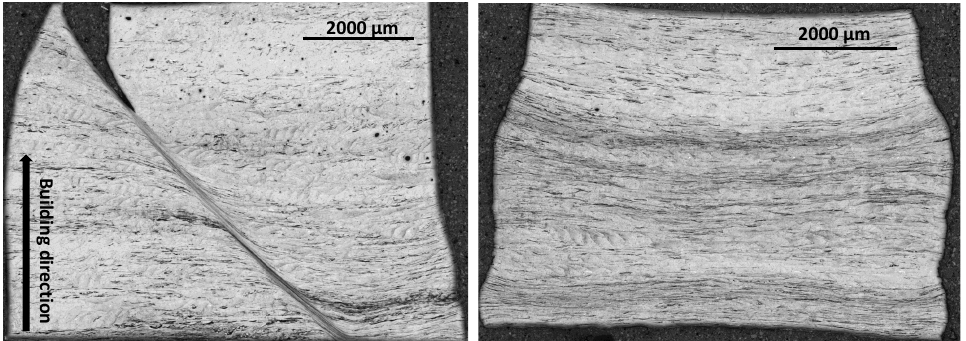
Figure 13. OM observations of Ti42Nb specimens manufactured with a building direction of 90 ◦ deformed at a strain rate of 10 s − 1 and two temperatures: ( left ) 298 K and ( right ) 1073 K.